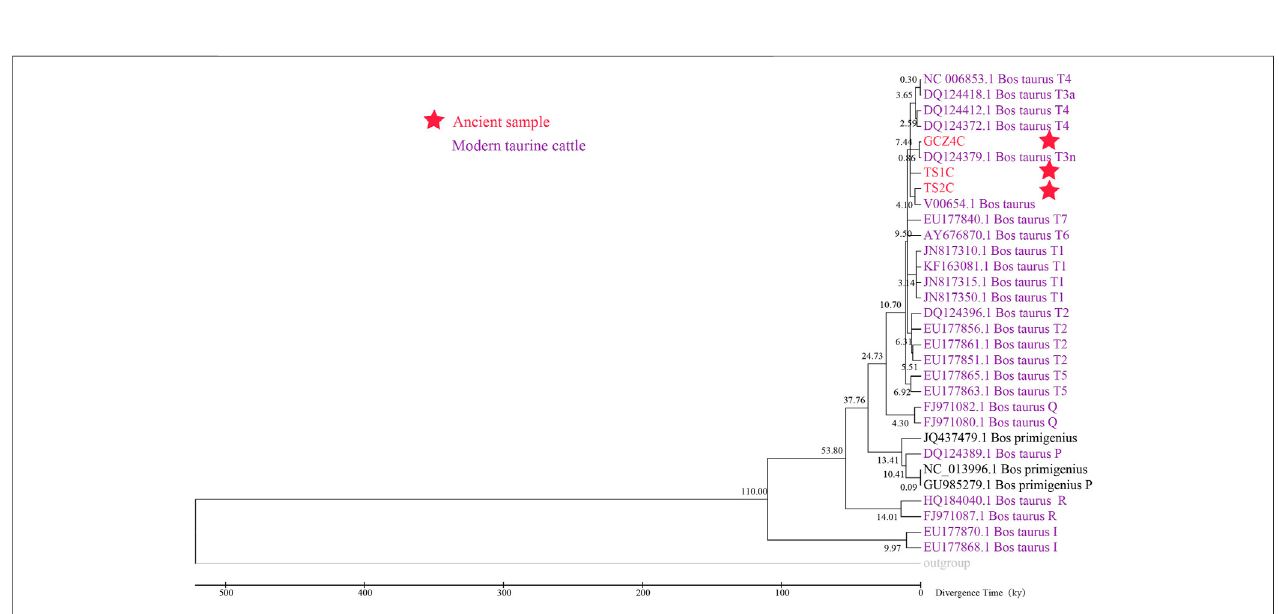
FIGURE 5 | The Maximum Likelihood timetree of ancient and modern Bos